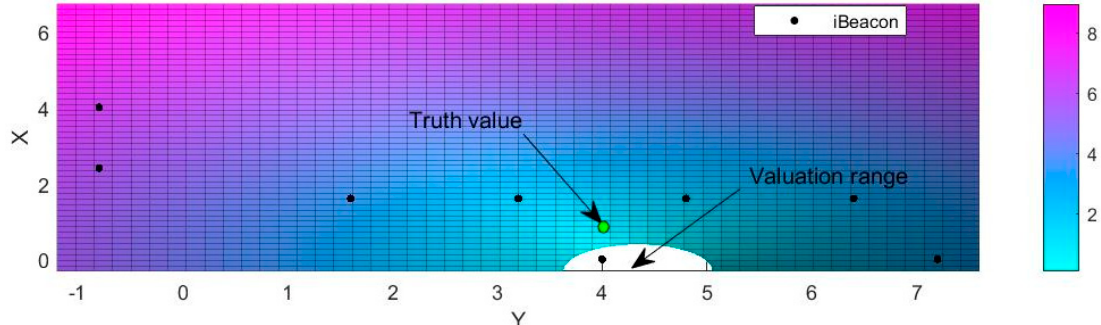
Figure 8. Coordinates solution.